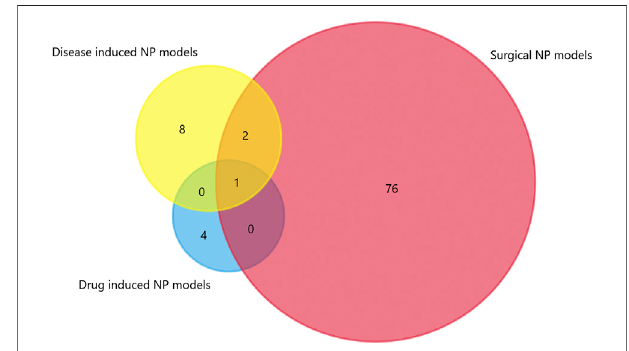
FIGURE 4 | The intersection of experimentally veri fi ed miRNAs in three typesofrodentNPmodels.OverlappingmiRNAs:2:miR-34c-5p,miR-145;1: miR-155.